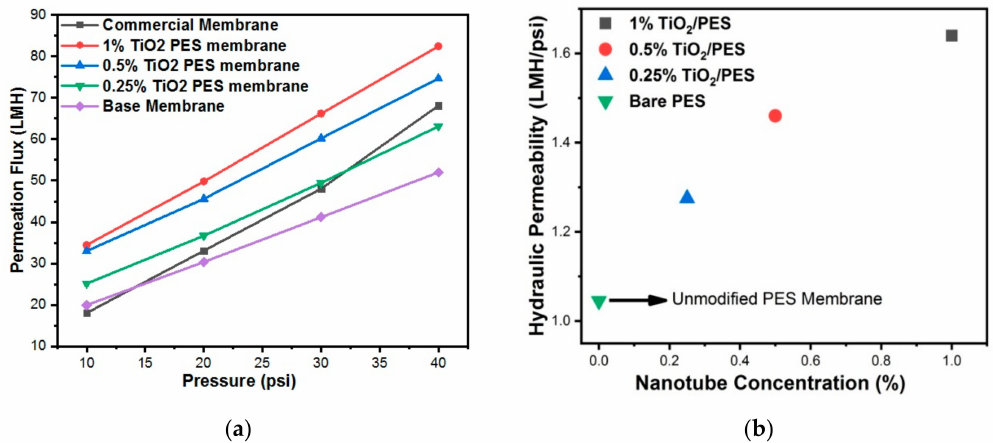
Figure 8. ( a ) Permeation flux as a function of transmembrane pressure; and ( b ) hydraulic permeability of membranes as a function of NT